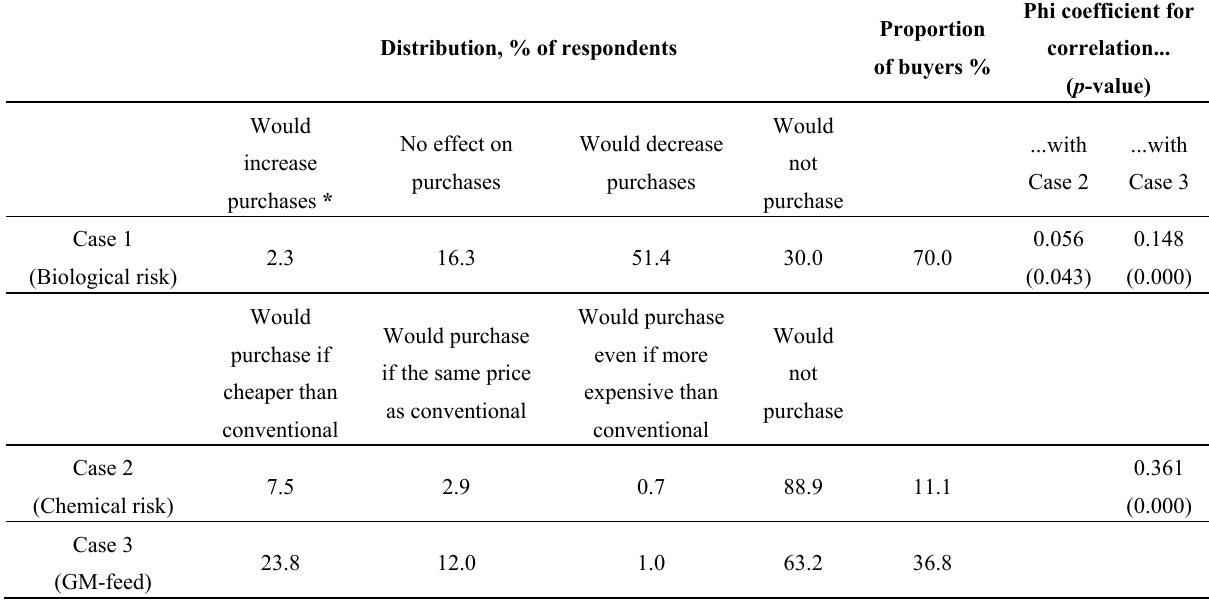
Table 4. Distribution of buyers based on purchase intentions, proportion of buyers, and correlation between the purchase intentions under different types of risk. Distribution, % of respondents